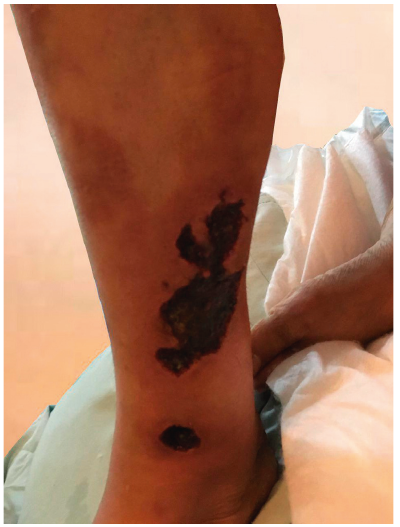
Figure 2: Rapid deterioration of ulcers and increase in the lesion size after 2